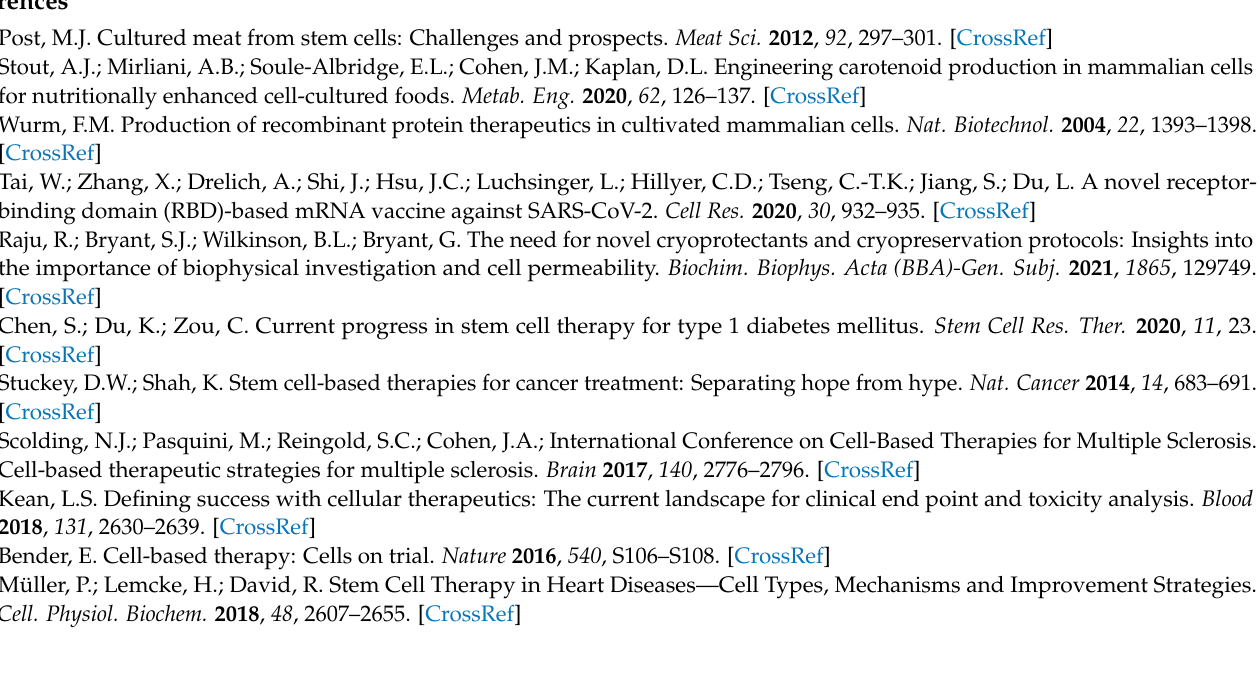
Figure S2: Gating strategy for flow cytometry assessment of EGFP–AFP transfection; Figure S3: The 24 and 48 h post-transfection microscopy images; Table S1: Average increased % viability of HEK 293T cells across treatments for extracellular (EC) AFP and intracellular (IC) AFP and